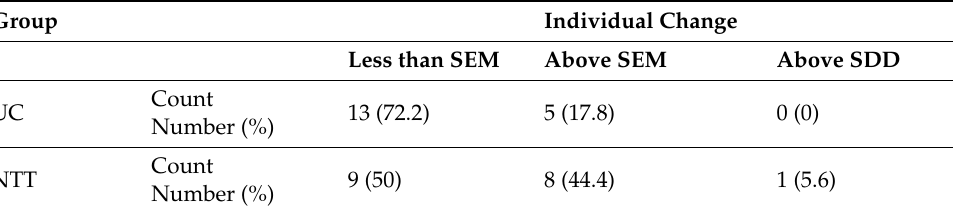
Table 4. Number of children that changed more than the Standard Error of Measurement (SEM: 2 and 3 standard points) and Smallest Detectable Difference (4 or more standard points) of MABC-2 total standard score per group, UC = usual care, NTT = neuromotor task